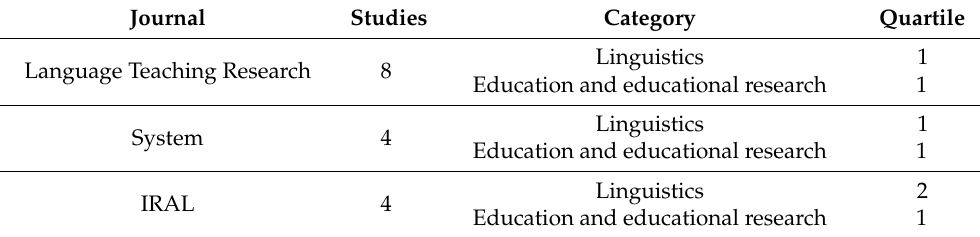
Table 1. Journals with three or more studies published.